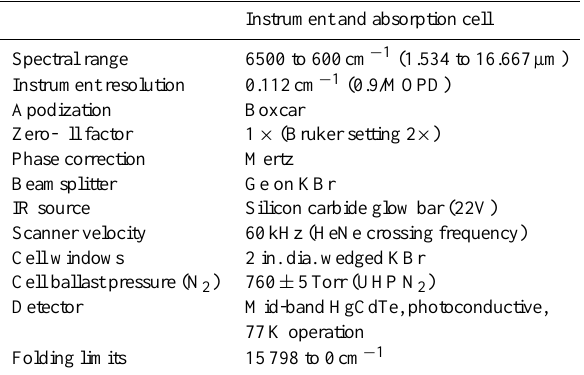
Table 1. Instrumental parameters for the isoprene